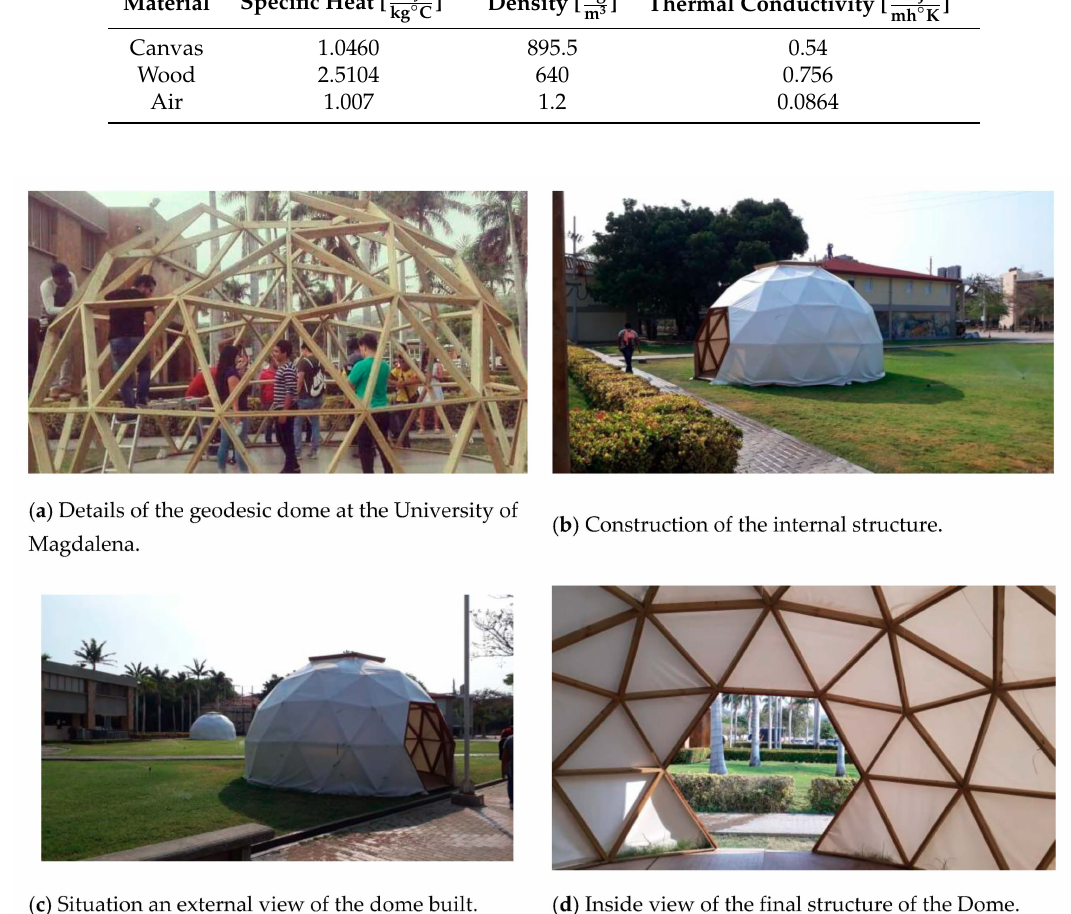
Figure 1. Building the geodesic dome at the University of Magdalena.